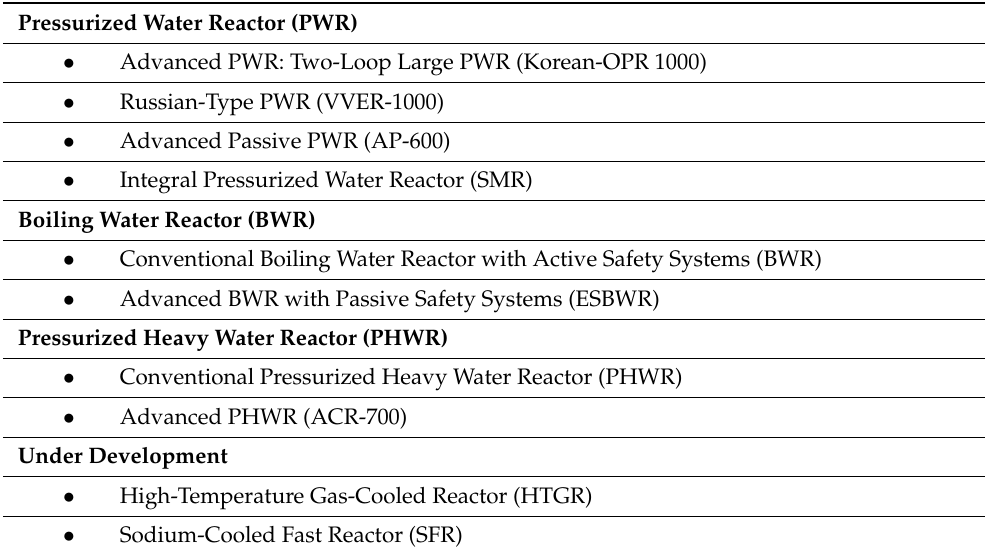
Table 1. Available nuclear reactor simulators [10].